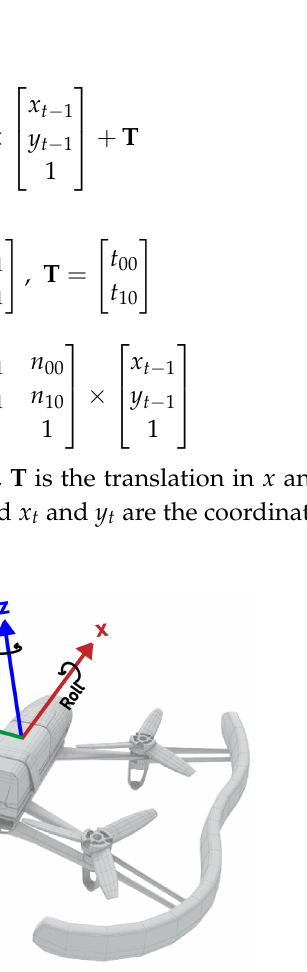
Figure 4. Pose of the MAV.